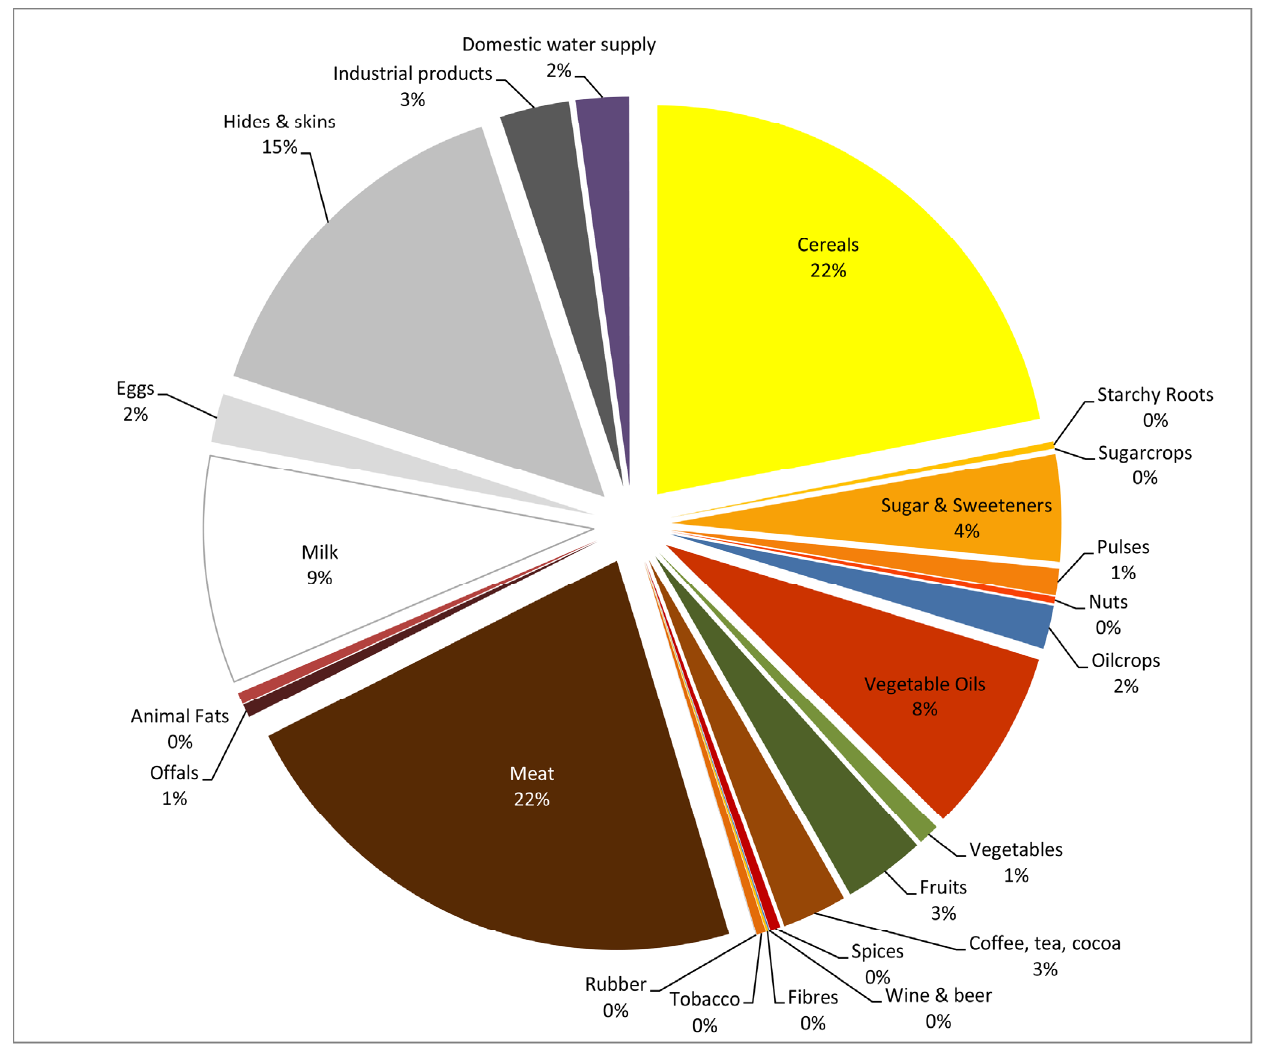
Figure 4. The average water footprint of a consumer in Jordan. Period: 1996–2005. Data based on